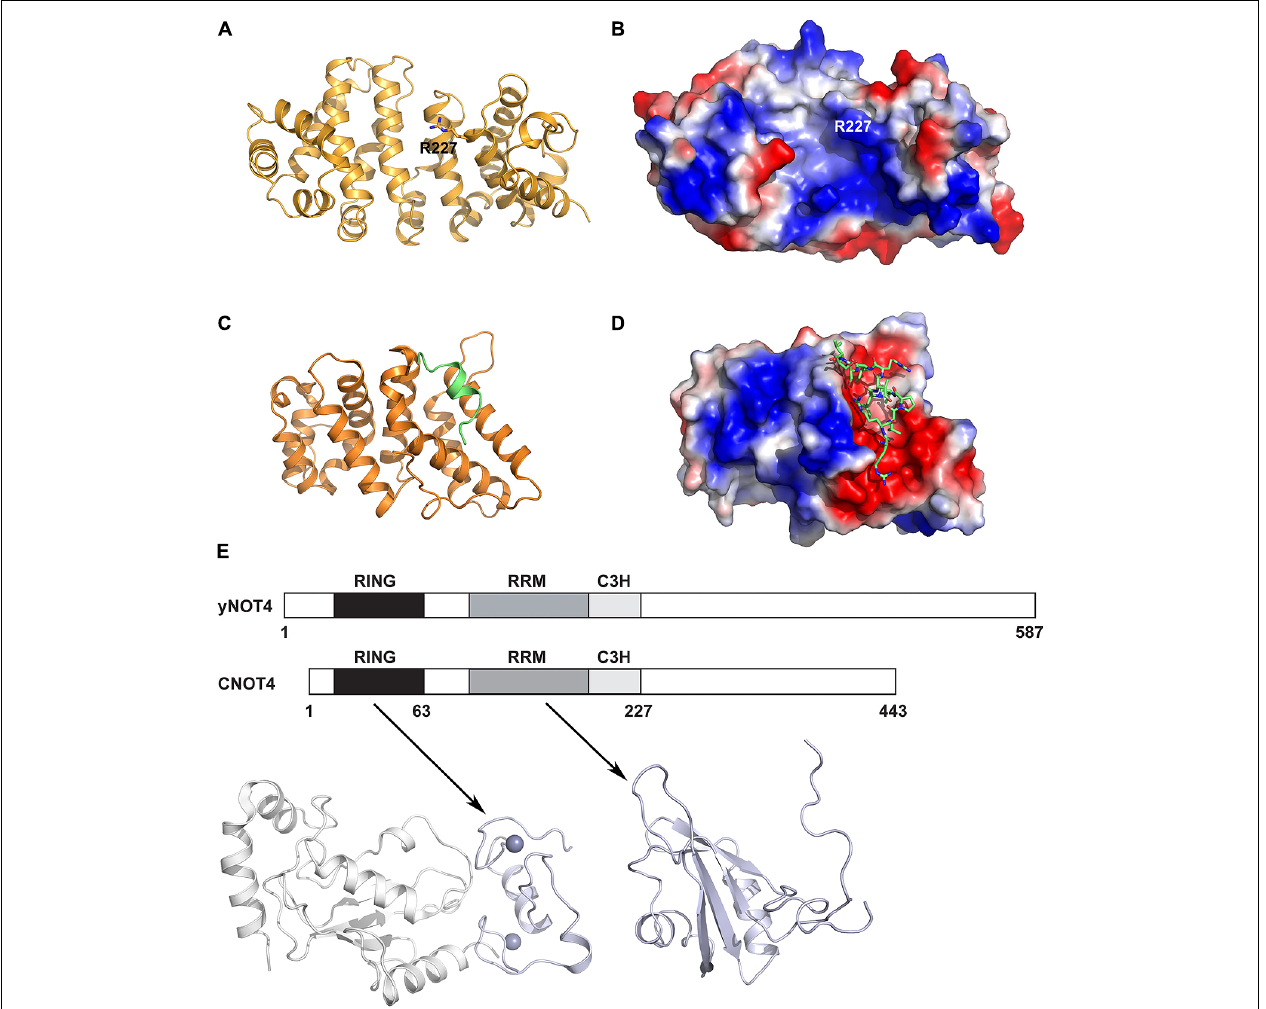
representation of the CNOT1 MIF4G domain showing the binding surface for theTTP peptide, shown in green stick representation. (E) The domain organization of yeast Not4 and human CNOT4. Shown below are the structural model of the human CNOT4 RING–UbcH5b complex (left; PDB ID: 1UR6) and the solution structure of the RRM (right, PDB ID: 2CPI) domain. The CNOT4 RING and RRM domains are shown in pale blue, and UbcH5b is shown in